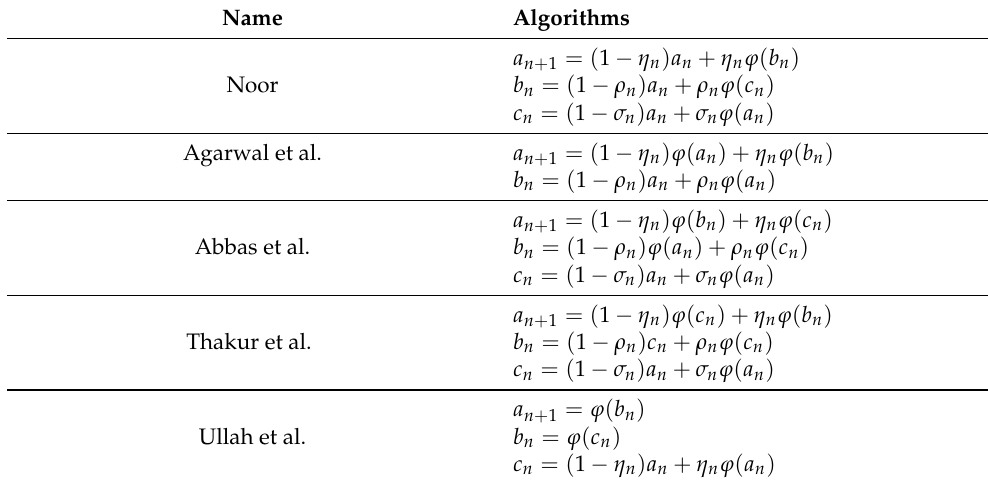
Table 1. Different Iterative